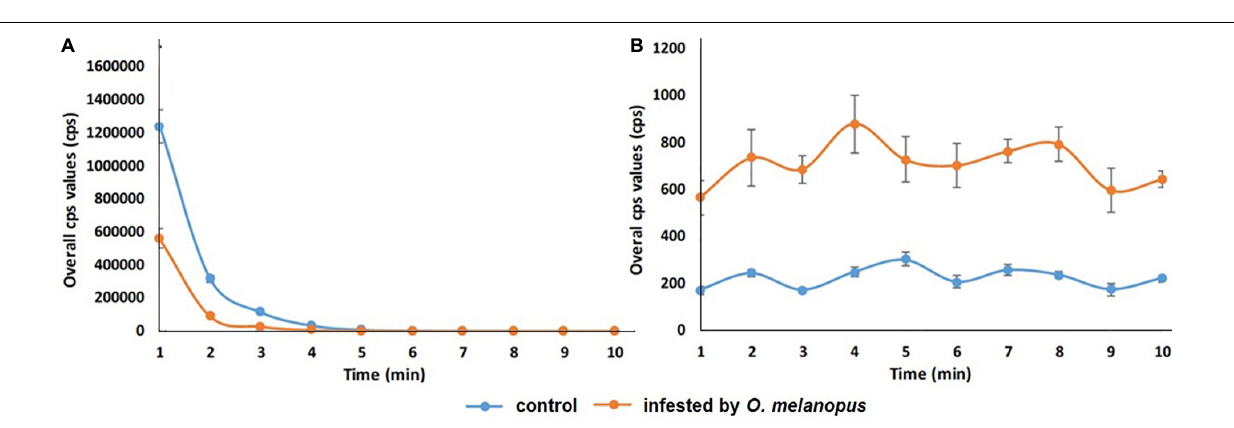
FIGURE 7 | Temporal changes of overall count per second (A) DF and (B) UPE values of control and O. melanopus -infested wheat during a 10-min measurement period. Mean values ( n = 5) and ± SD are